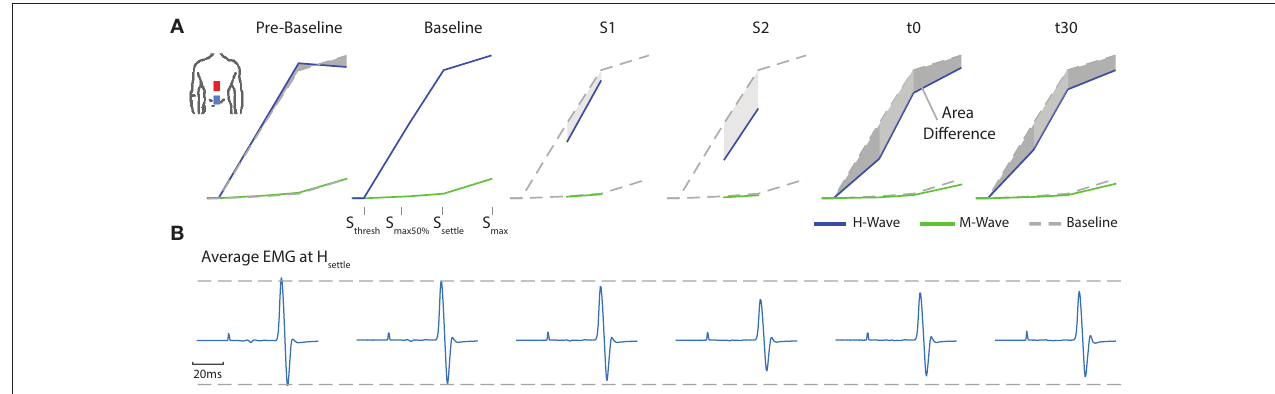
FIGURE 4 | For an exemplary subject (A) all average H- and M- Wave datapoints are shown. For clarity, the figure exemplifies the area between a corresponding measurement and baseline. (B) Average EMG traces at H settle for configuration ED-C.